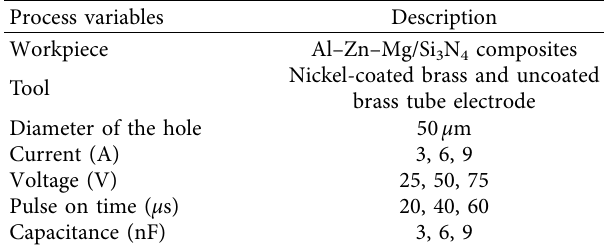
Table 5: Experimental run